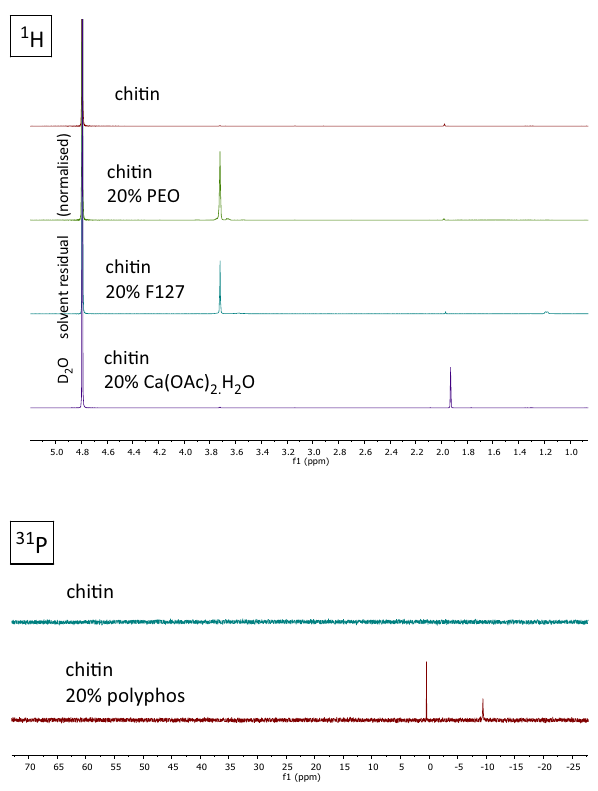
Figure 4. Additive release from patches: 1 H and 31 P NMR in D 2 O. For experimental details see Supplementary